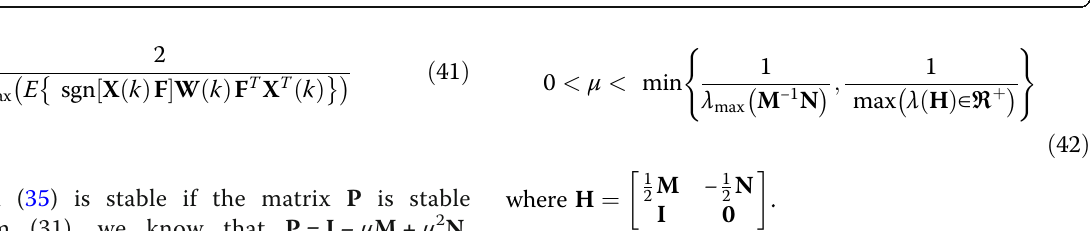
Fig. 7 NMSD learning curves of NSAF, DS-NSAF, FS-NSAF, SPU-NSAF, SR-NSAF, and MSR-NSAF with N =